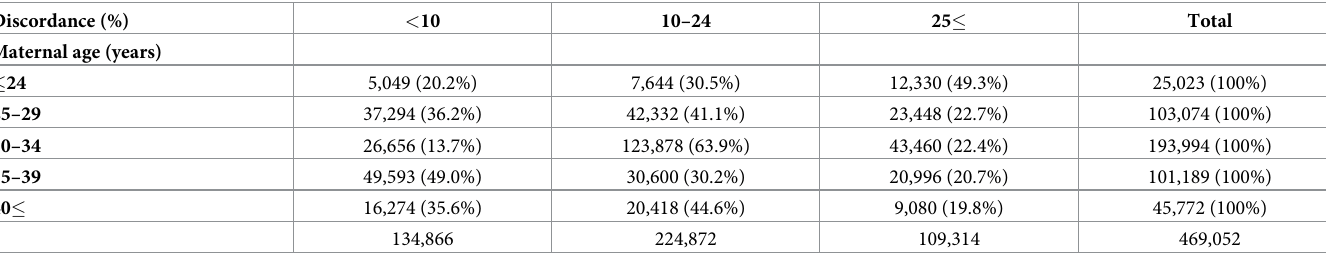
Table 6. Relationship between maternal age and weight difference of babies who died within 1 year.